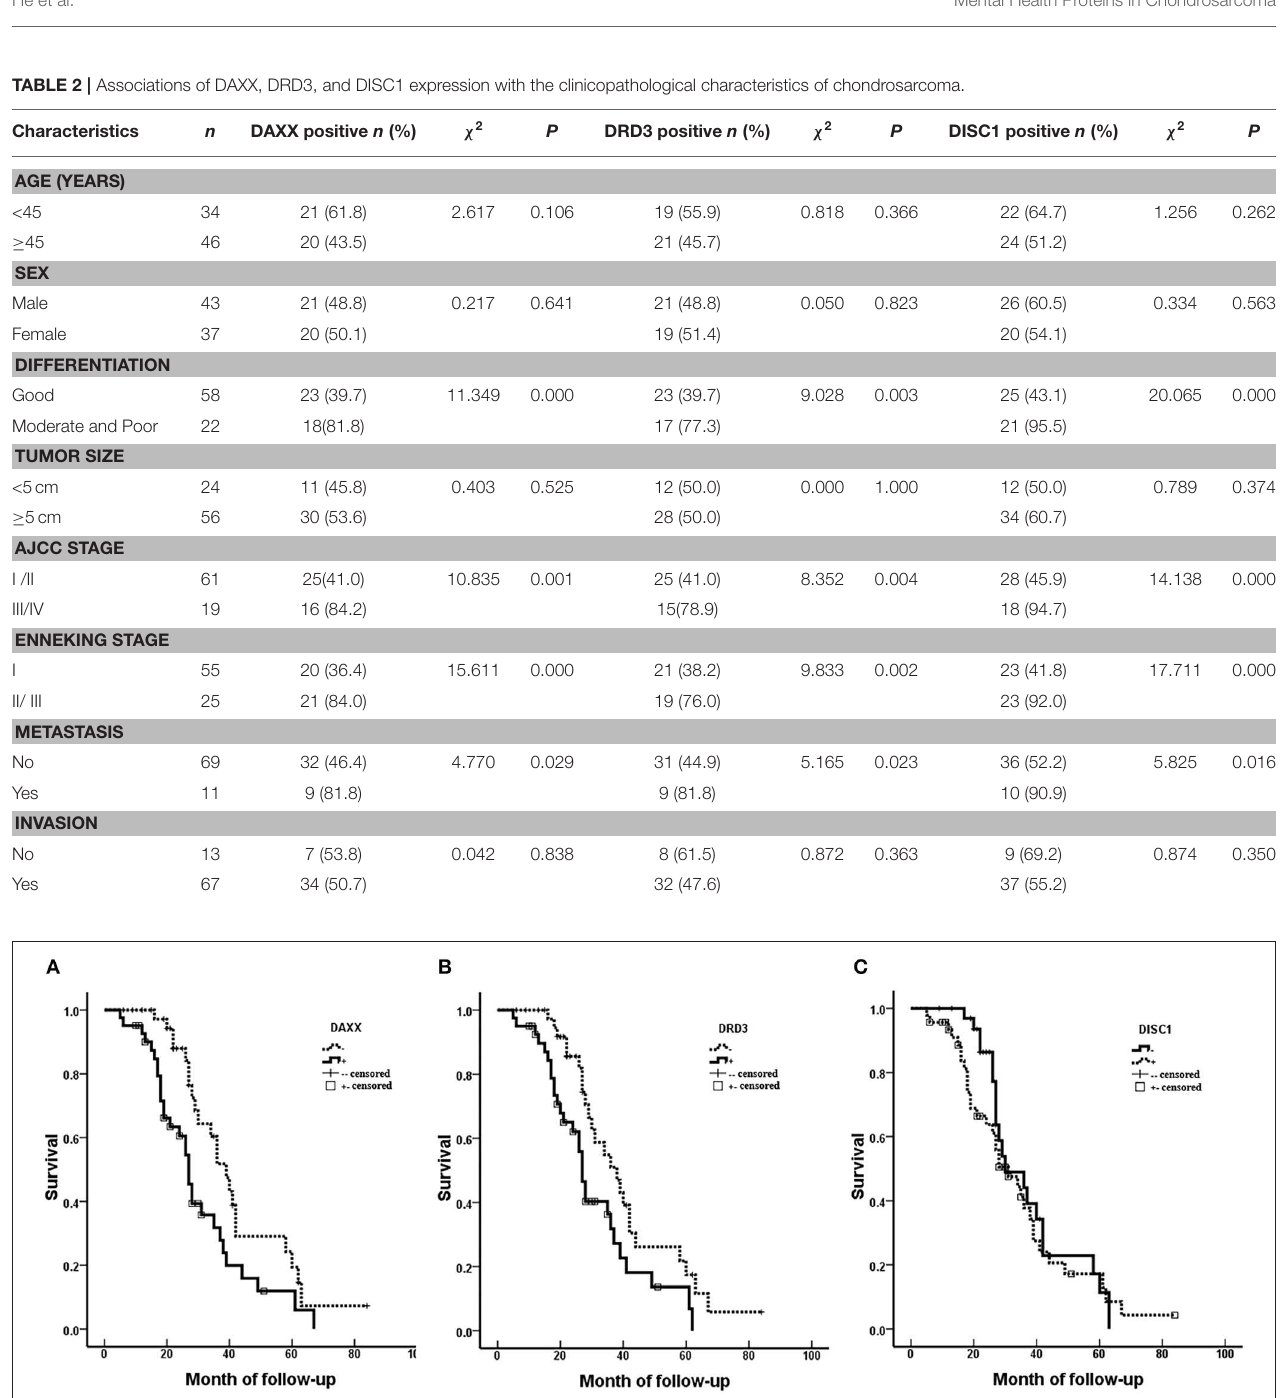
negative. Significant positive correlations were found between the expression of DAXX and DRD3 ( χ 2 = 36.473, P = 0.000), DAXX and DISC1 ( χ 2 = 22.25, P = 0.000), and DRD3 and DISC1 ( χ 2 = 20.46, P <